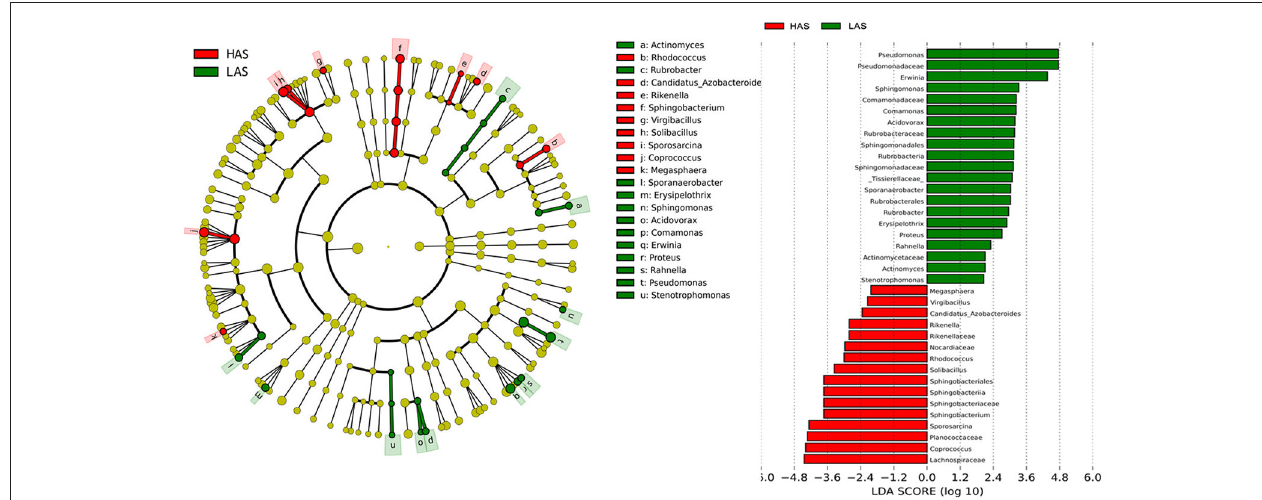
FIGURE 2 | LEfSe identified taxons for HAS and LAS. (Left) Taxonomic cladogram. (Red) Taxa enriched in HAS or LAS are colored by red or green, respectively. (Right) HAS-enriched taxa are shown with a positive LDA score (green), and taxa enriched in LAS are shown with a negative score (red). Only taxa meeting an LDA significant threshold > 2 and p < 0.05 are shown.